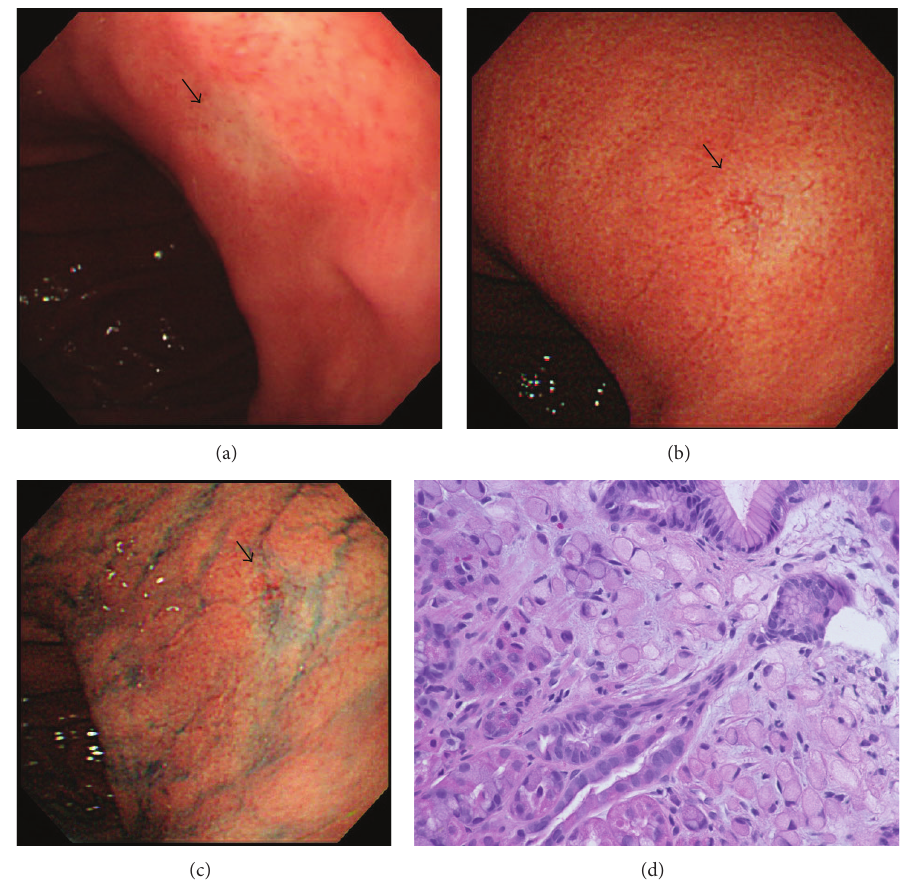
Figure 1: Endoscopic examination before treatment. Conventional white-light endoscopy in October 2011, when the initial examination was carried out ((a) arrow: SRGC lesion). Conventional white-light endoscopy in January 2013, when initial diagnosis was made ((b) arrow: SRGC lesion), and with indigo-carmine dye staining added to acetic acid in January 2013 ((c) arrow: SRGC lesion). The biopsy specimen revealed signet ring cells ((d) ×